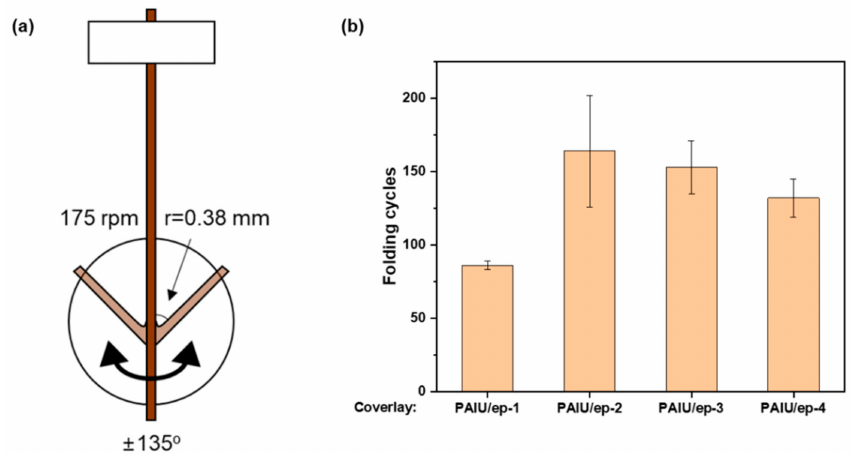
Figure 7. Measurements of folding endurance: ( a ) schematic of the folding endurance test; ( b ) the folding cycles measured until the Cu patterns on the FPCBs containing PAIU/epoxy IPNs as coverlays were